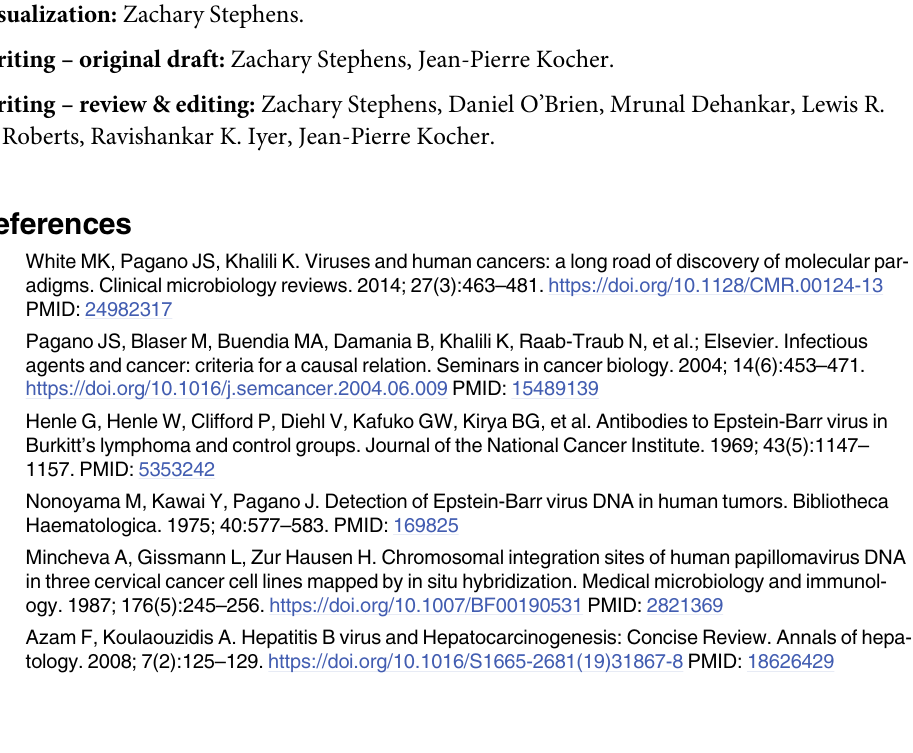
S1 Fig. Exogene logic got selecting representative alignments for multi-mapped reads. (TIFF) S1 File. All HBV integrations in targeted capture